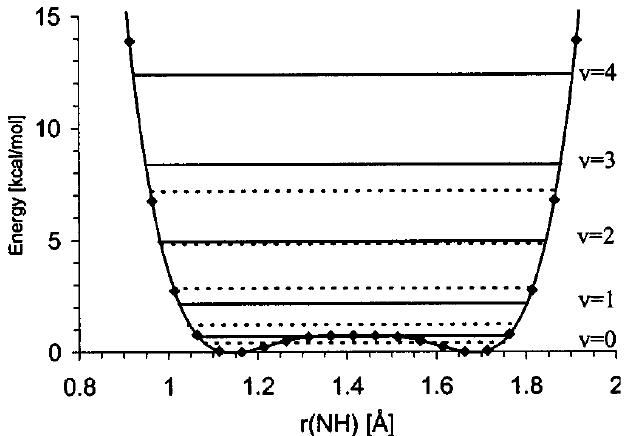
Figure 8. The potential energy curve for protonated 2,7-dibromo-1,8-bis(dimethylamino)naphthalene obtained by MP2/6-31+G(d,p) level of theory. Reprinted with permission from [79]. Copyright 2008 AIP Publishing.